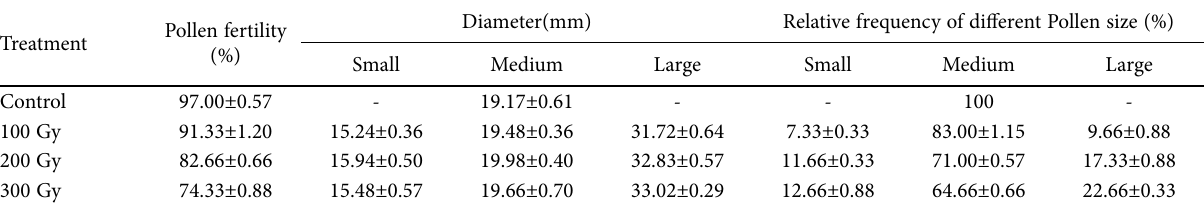
Table 2. Impact of Gamma rays on Pollen fertility and Relative pollen size frequency in Cluster bean [ Cyamopsis tetragonoloba (L.) Taub.].